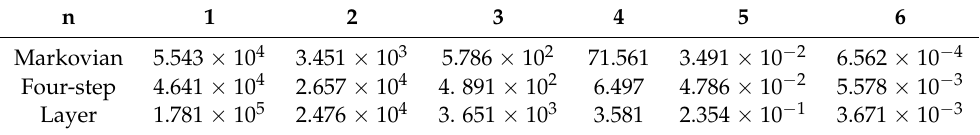
Table 1. The errors of ˆ Y t between the numerical methods and the Euler method on the FBSDEs. n 1 2 3 4 5 6 Markovian 5.543 × 10 4 3.451 × 10 3 Four-step 4.641 × 10